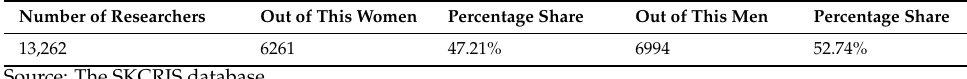
Table 1. Researchers involved in project implementation.